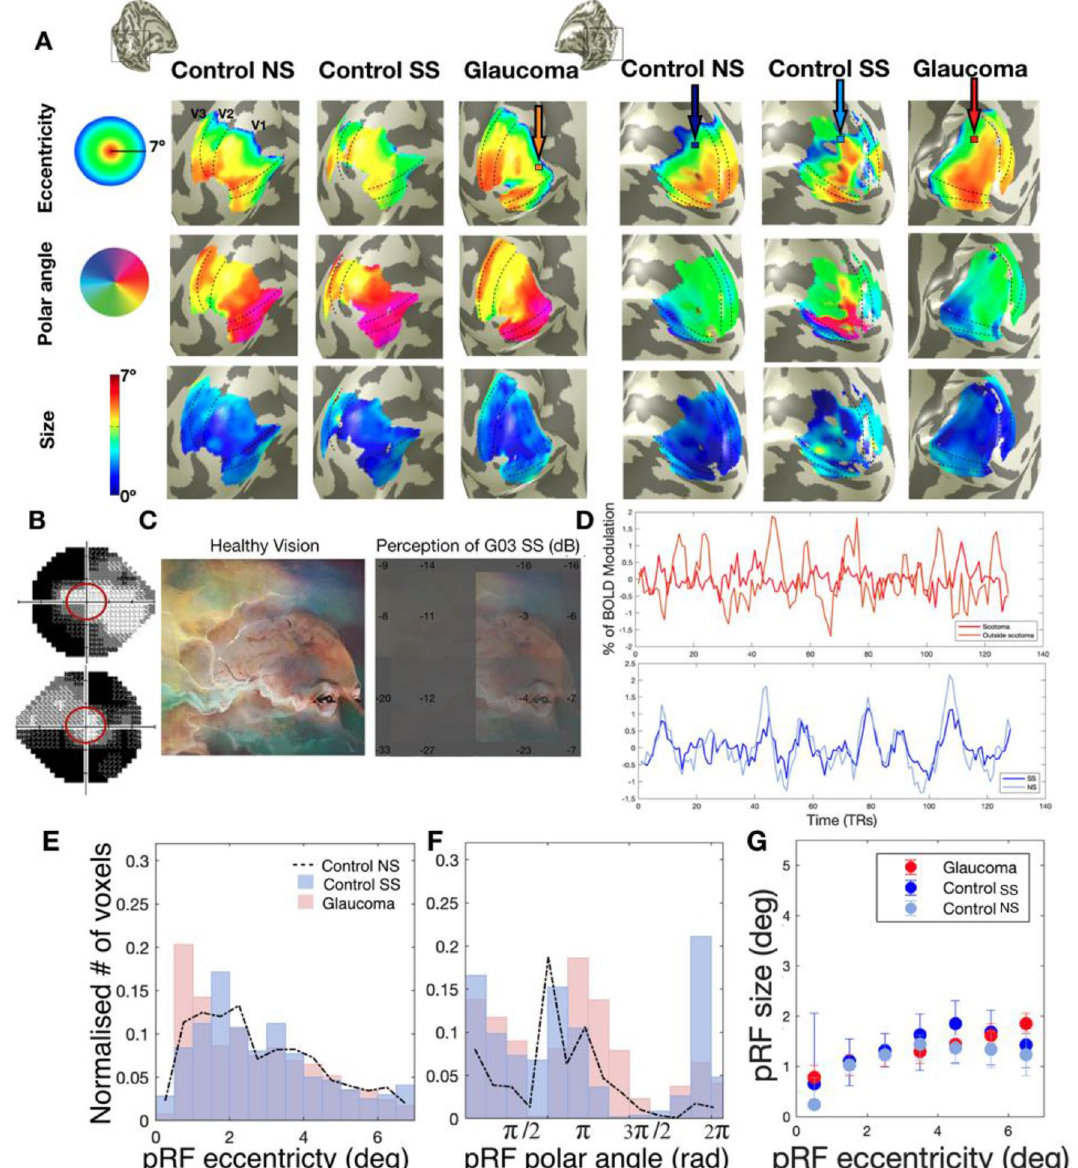
Figure 2. Preserved cortical organization in glaucoma. ( A ) Eccentricity, polar angle, and pRF size maps obtained for a participant with glaucoma (G03), and their respective control participant (C03) with (SS) and without (NS) a matched simulated scotoma. The maps were obtained using a explained variance threshold of 0.1 The dashed lines delineate the visual areas V1, V2 and V3. ( B ) VFs for the left and right eye of the participant with glaucoma. The red line corresponds to the VF that can be mapped using fMRI (7° radius), ( C ) Representation of the visual perception of a participant with healthy vision (Left) and of glaucoma participant G03 (right). The binocularly integrated contrast sensitivity values (dB) are superimposed on the image. ( D ) Example of V1 time series (arrows in the top row of figures of ( A ) show the voxel locations). The upper panel in ( D ) shows the time series of a voxel of G03 in their SPZ (red arrow) and of a voxel with a similar pRF position but located in the contralateral hemisphere (orange arrow). The lower panel in ( D ) shows for C03 the time series of a voxel located in their simulated SPZ during the NS (dark blue arrow) and SS conditions (light blue arrow), respectively. ( E , F ) Histogram of the normalized number of responsive V1 voxels (i.e.variance explained (VE) > 15%), as a function of eccentricity and polar angle, respectively. G03 is depicted in red and C03 in the simulation condition in blue (Control SS, i.e. the simulation matched to G03). C03’s results in the no simulation (NS) condition are depicted by the dashed black line. ( G ) V1 PRF size as a function of eccentricity for G03 (red) and C03 in the conditions NS (light blue) and SS (dark blue). The error bars correspond to the 95% confidence